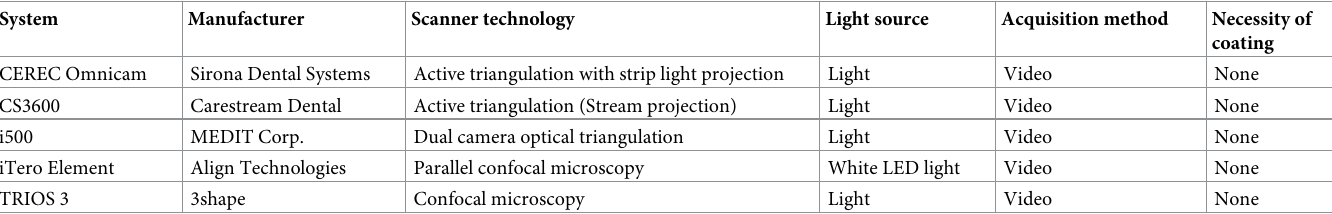
Table 1. Characteristics of intraoral